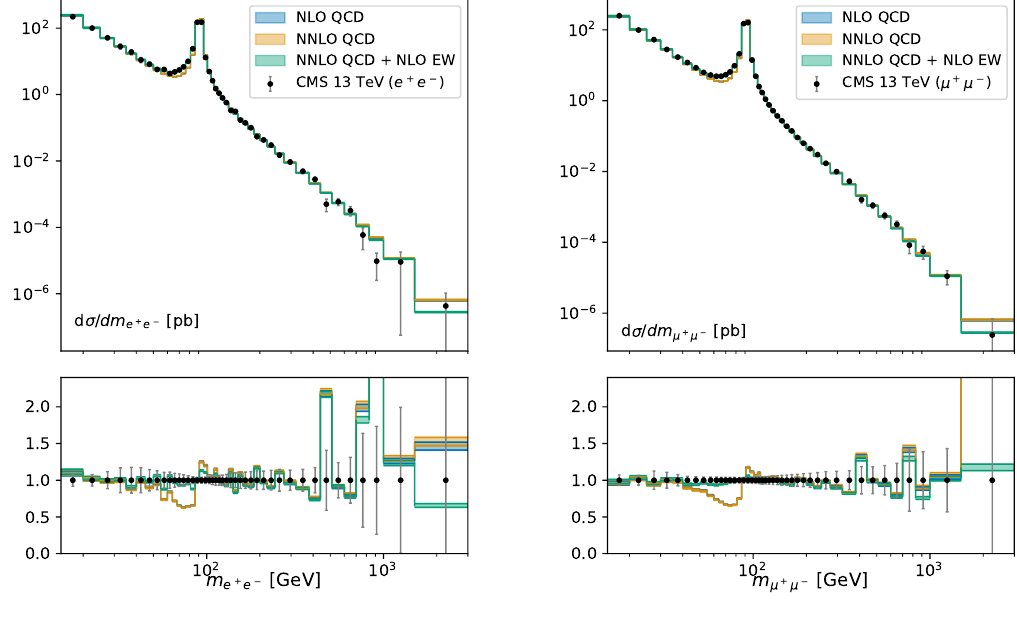
Figure 1 . Comparison of the CMS Drell-Yan 13 TeV data with the corresponding theoretical calculations at different perturbative orders as a function of the dilepton invariant mass m ‘‘ in the dielectron (left) and dimuon (right panel) final states. The bottom panels display the ratio of the theory calculations to the central value of the experimental data. We display the sum in quadrature of the experimental uncertainties, and the error band in the theory predictions correspond to the one-sigma PDF